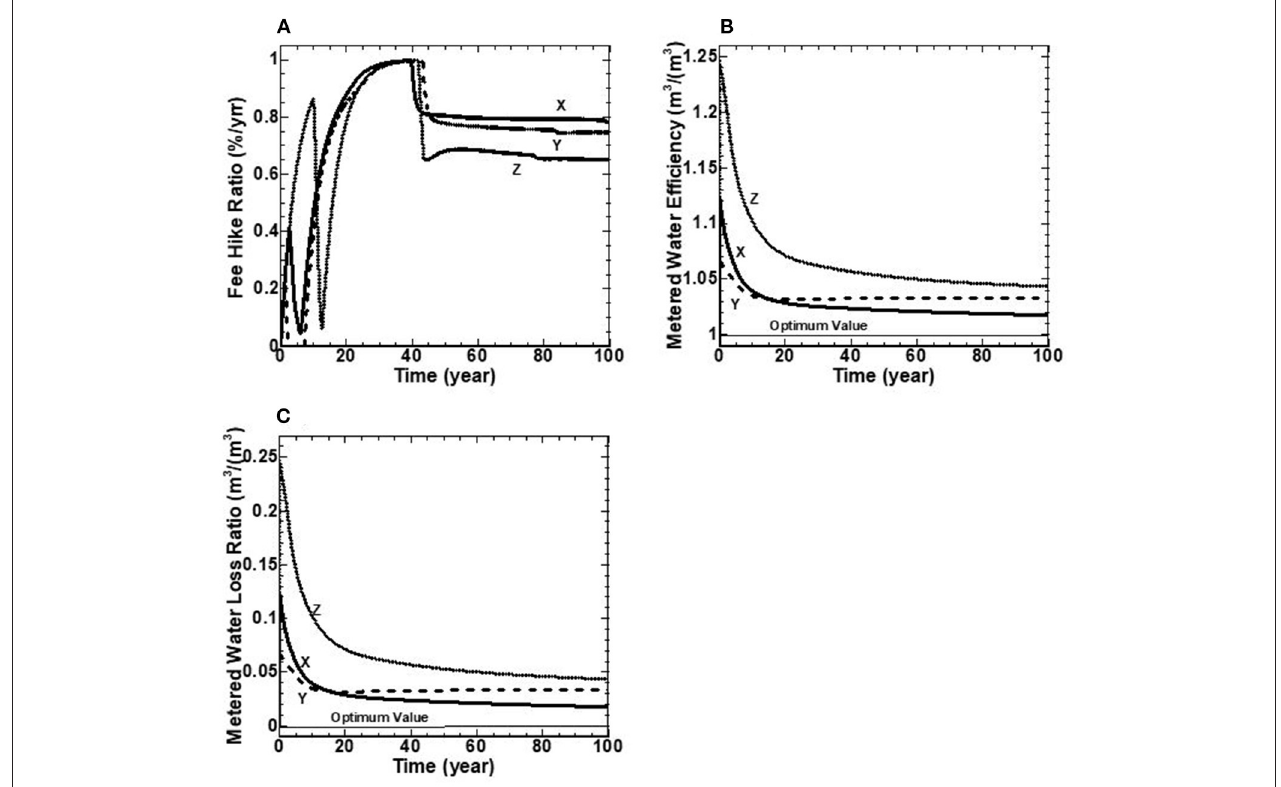
FIGURE 7 | (A–C) Water socio-political indicators over a 100-year benchmarking period for utilities X, Y, and Z.